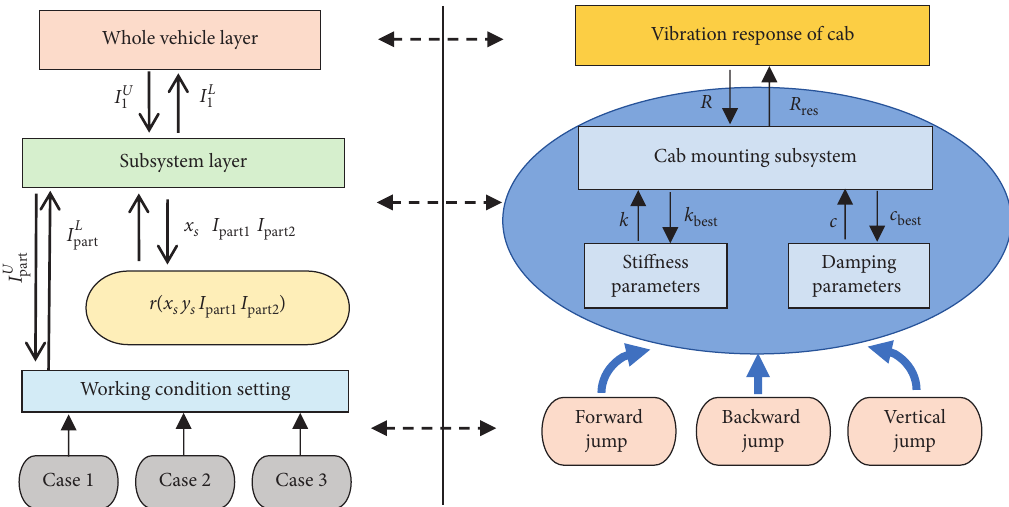
Figure 1: Parameter hierarchical interaction model.